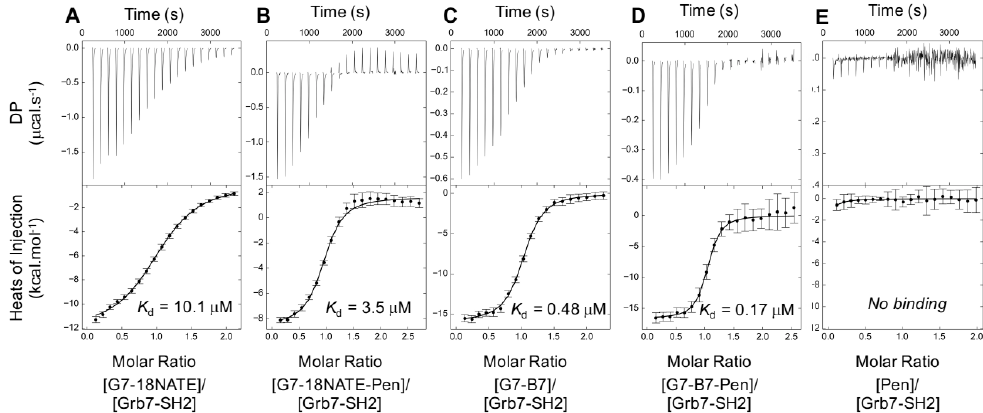
Figure 7. Isothermal titration calorimetry (ITC) analysis of Grb7-SH2 and G7-targeting peptides. Thermograms of ( A ) G7-18NATE, ( B ) G7-18NATE-Pen, ( C ) G7-B7, ( D ) G7-B7-Pen, ( E ) Pen titrated